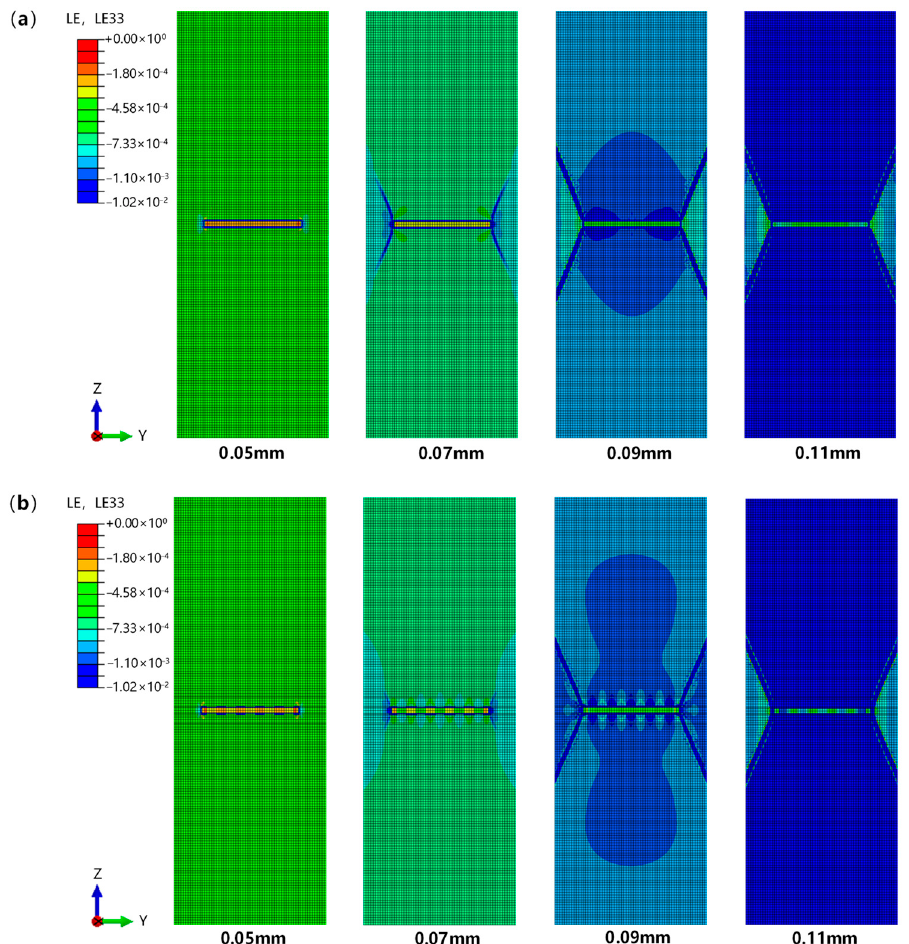
Figure 17. Strain distribution along the z direction in regions surrounding the 0° ( a ) flat and ( b ) rough sensors under progressive compressive displacements.